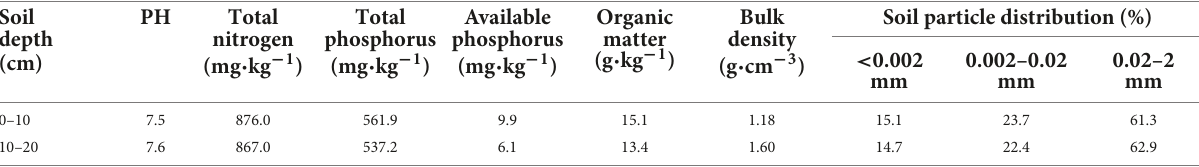
TABLE 1 Basic properties of soil at 0–20